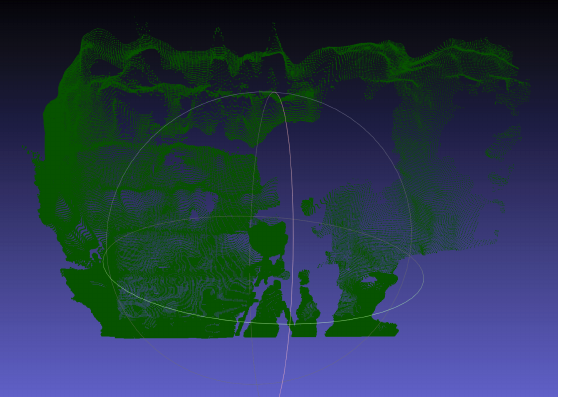
Figure 16. The 3D point cloud is observed in the format PLY using Meshlab software, without detecting any object.